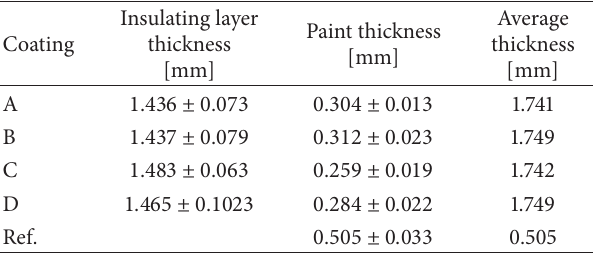
Table 2: Average thickness of